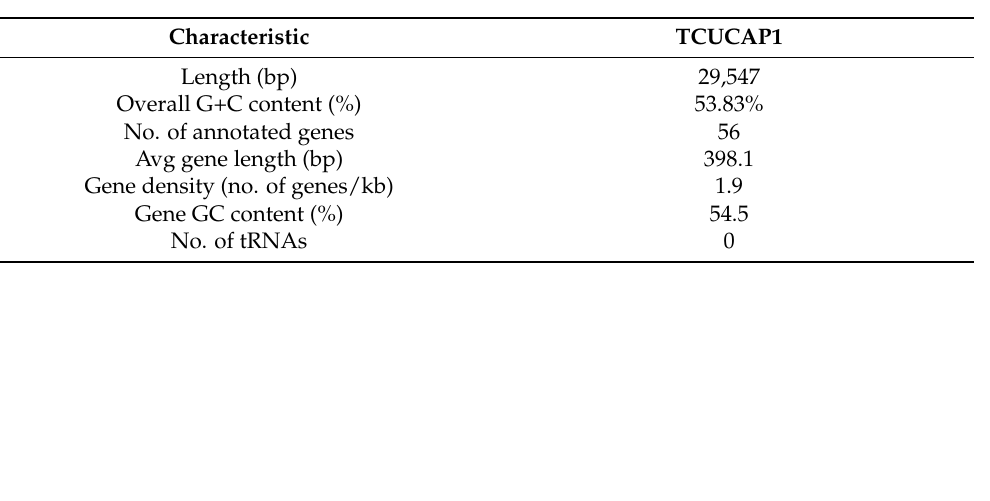
Table 2. General characteristics of the bacteriophage TCUCAP1